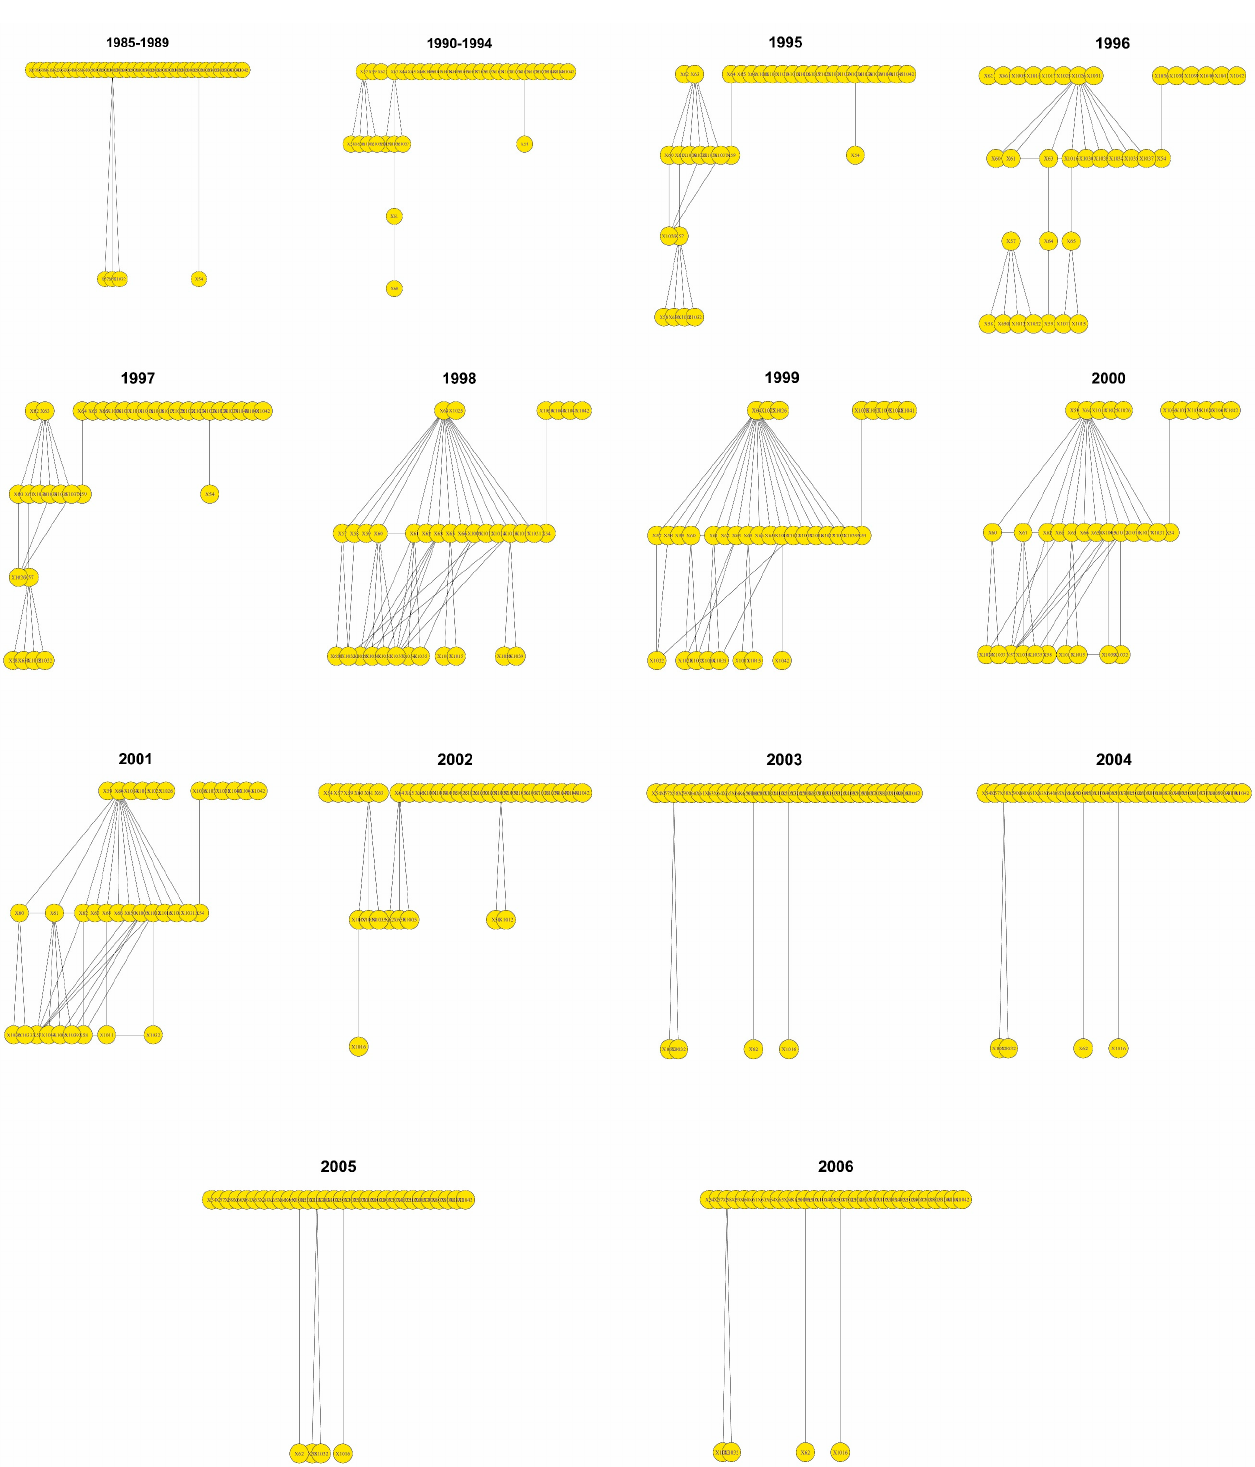
Figure 2. Temporal development of the hierarchical structure of “Hamburg Cell”. We observe a change of centralization during 1998–2001.